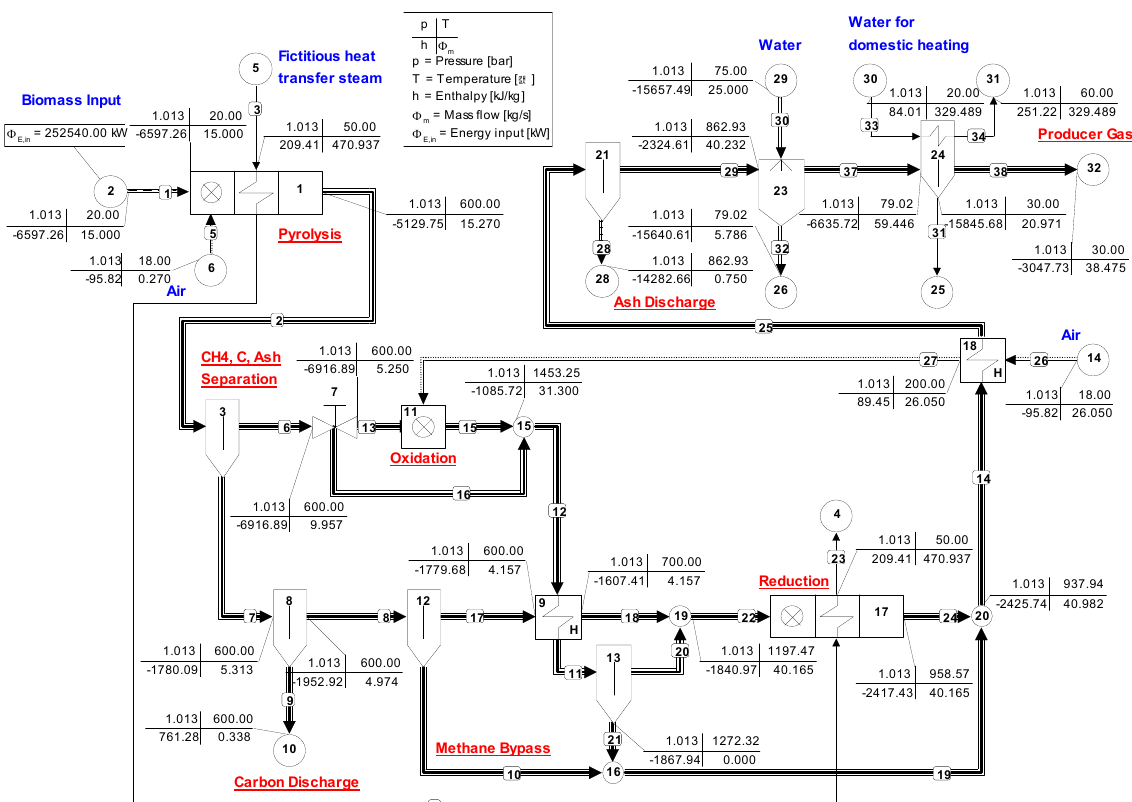
Figure 3. Three ‐ reactor model of biomass downdraft gasifier. Figure 3. Three-reactor model of biomass downdraft